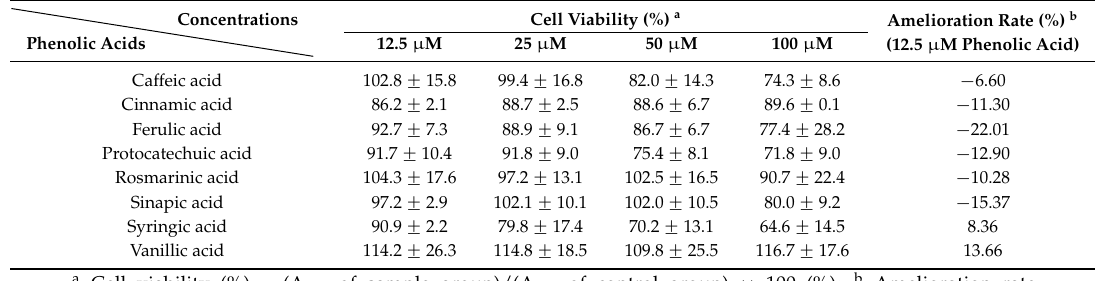
Table 1. Effects of various concentrations of phenolic acids on cell viability and amelioration rate of glucose uptake in insulin-resistant FL83B